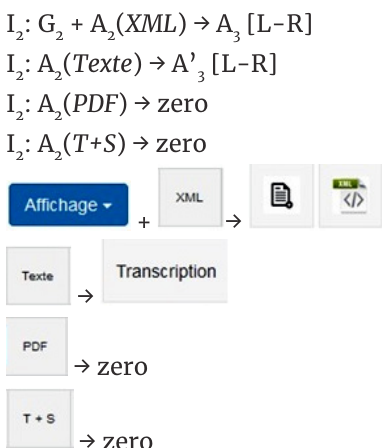
The scan element from A joined the two elements for one- and multiple-page 2